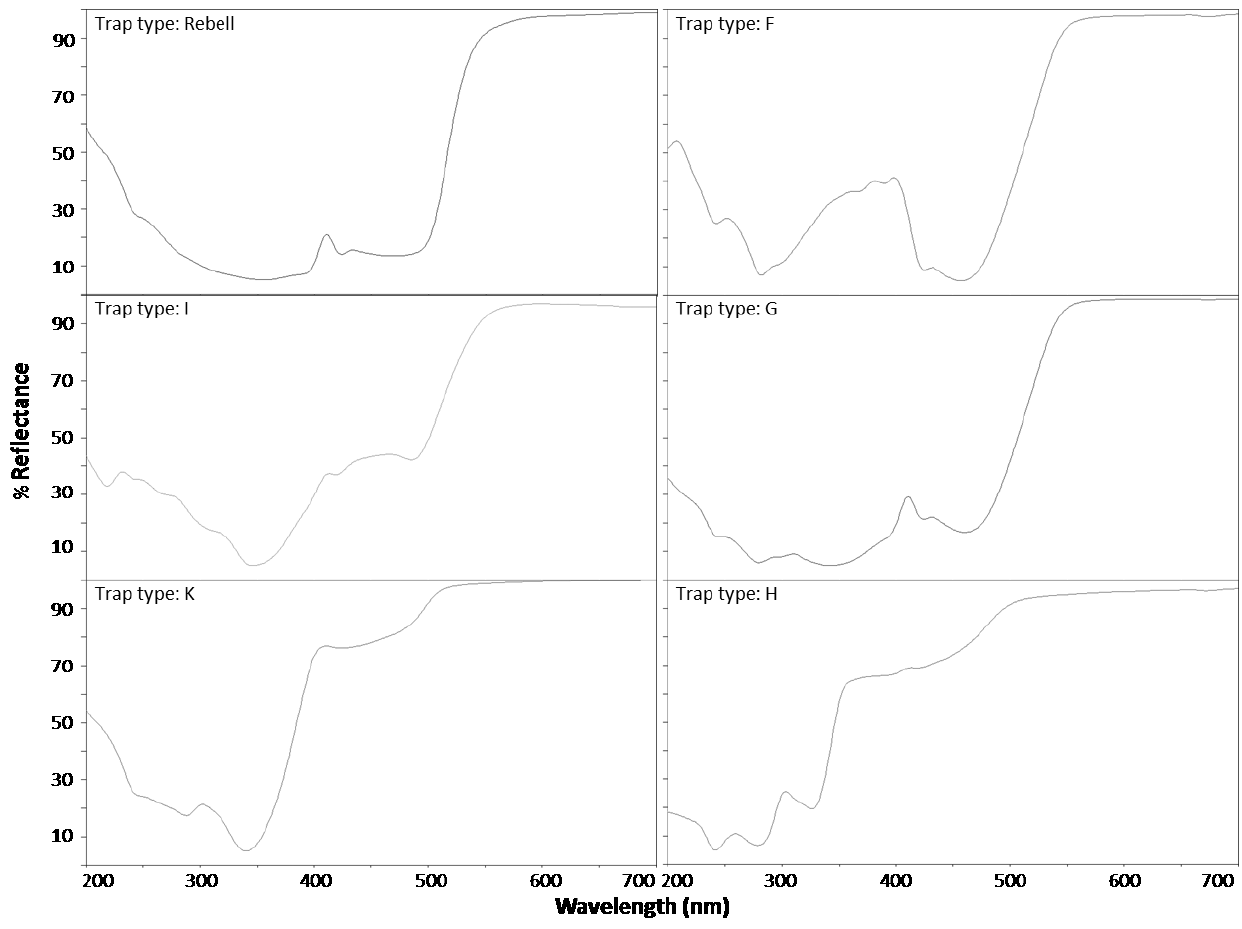
Figure 1. Spectral reflectance curves for the six differently colored panels (without Tangle-Trap) compared in Experiment